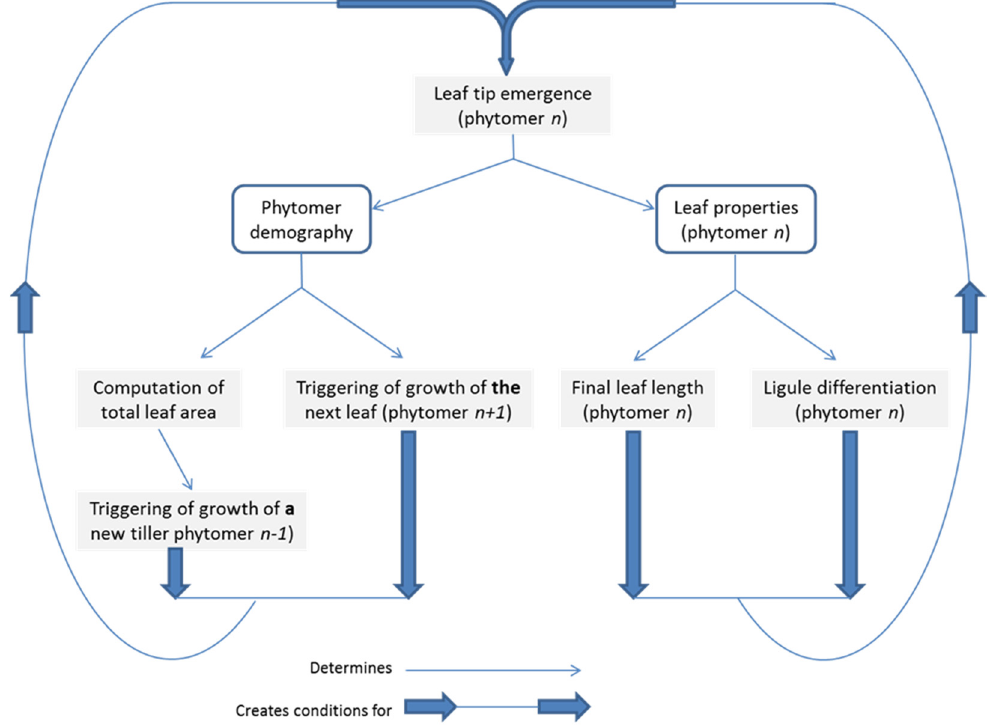
Figure 5. Diagram showing the cybernetic scheme implemented in the model.